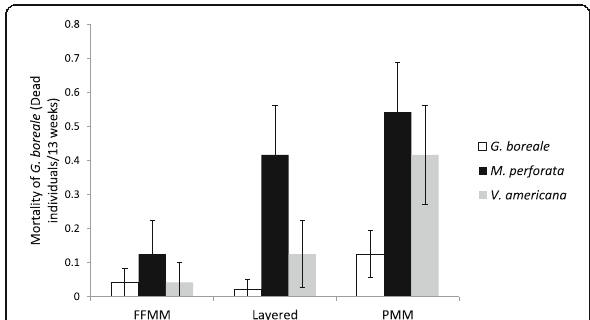
Fig. 4 Mortality of G. boreale across soil treatments (forest floor-mineral mix, layered, and peat-mineral mix) and competition with other species over 13 weeks. The different plant species represent the plants that were competing with G. boreale in competition pots. All bars represent G. boreale mortality. Error bars indicate standard error for each species